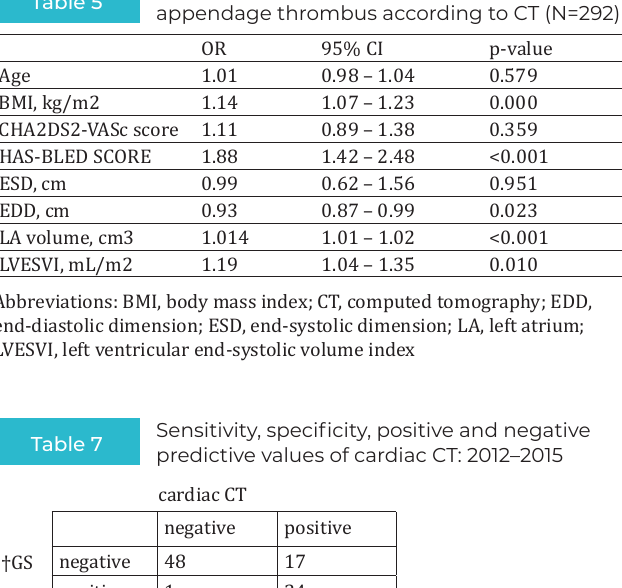
Sensitivity, specificity, positive and negative predictive values of cardiac CT: 2012–2020